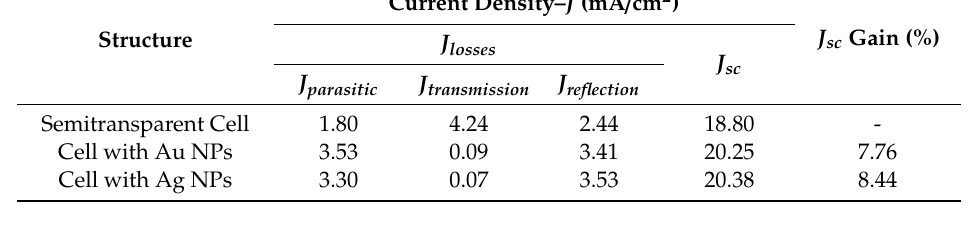
Table 6. Current Density Analysis comparison for the three different cell structures.